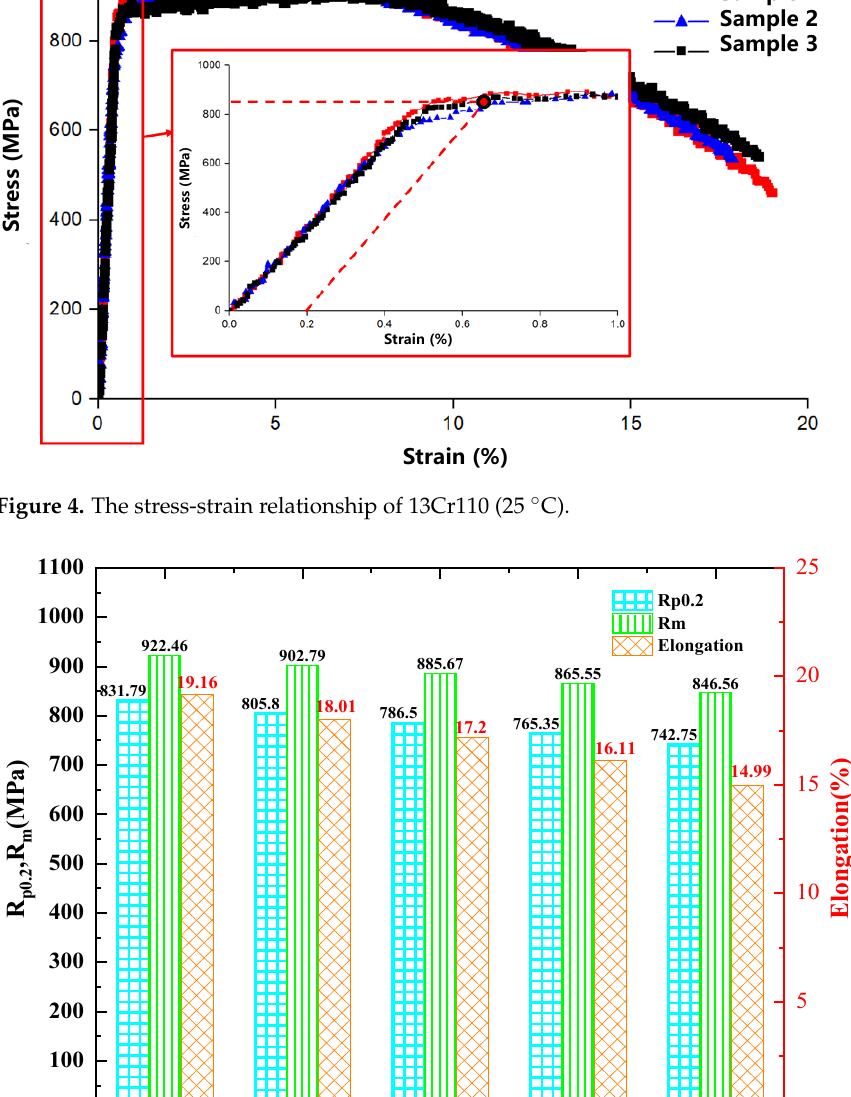
Figure 4. The stress-strain relationship of 13Cr110 (25 °C). Table 1. Static mechanical properties of the 13Cr110, as extracted from the stress-strain curves (25 °C).